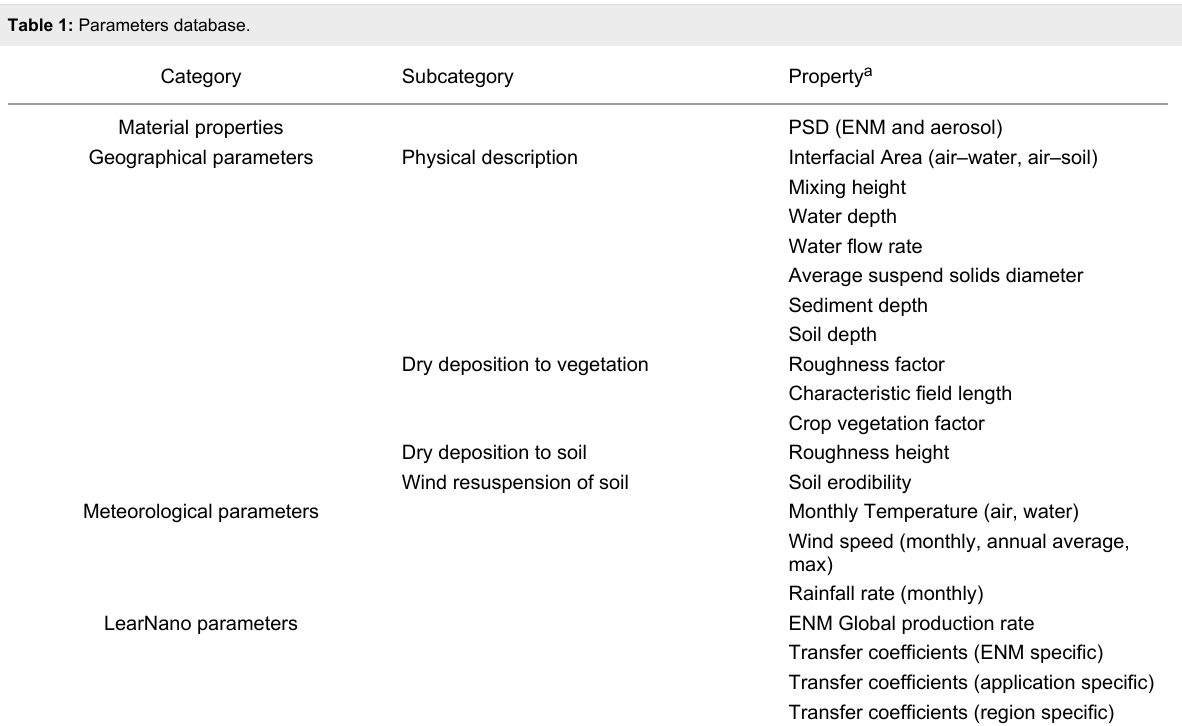
Table 1: Parameters